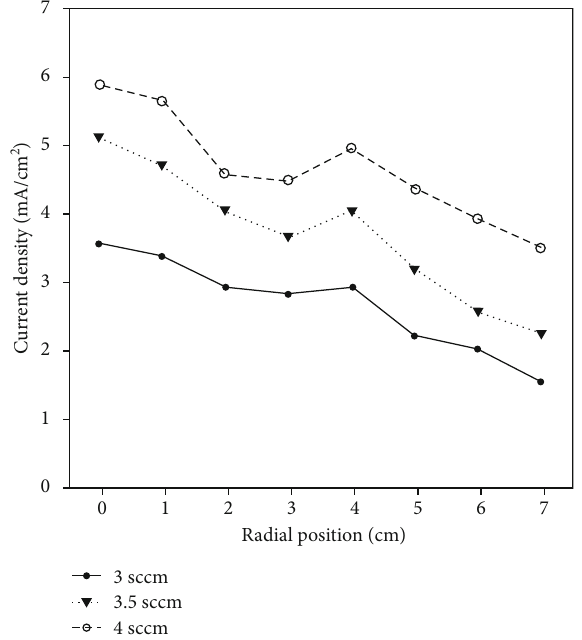
Figure 9: Current density distribution in radial position for various fl ow